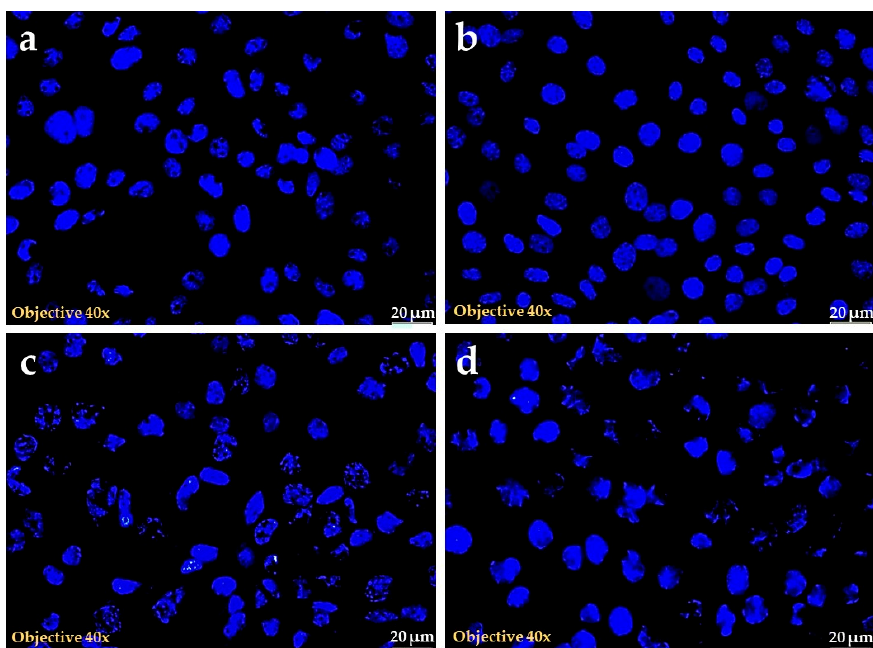
Figure 4. Hoechst nuclear stained MCF-7 cells after SMBM treatment. The groups represent ( a ) control, ( b ) SMBM 5 μ g, ( c ) SMBM 10 μ g and ( d ) SMBM 20 μ g. The blue fluorescence in the figure confirms the nuclear binding of Hoechst stain. The cells treated with 5, 10 and 20 μ g of SMBM shows evidence of dose dependant cell death compared to the control.